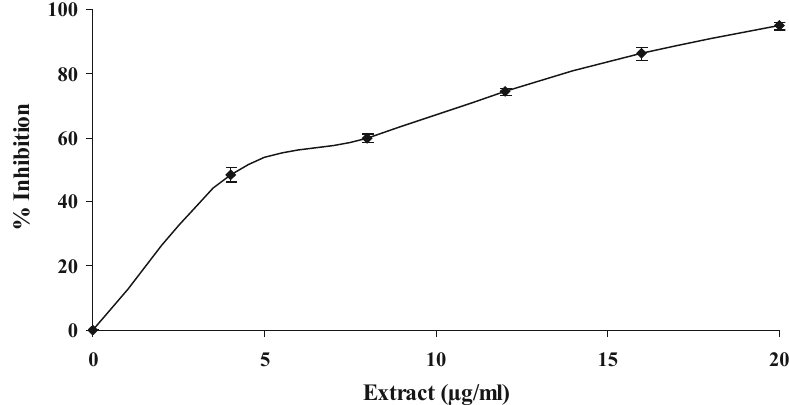
Figure 1 - Dose dependent inhibition of in vitro PLA by aqueous stem bark extract of M. indica . Brie fl y, Phosphatidyl choline (PC) corresponding to 1000 nmol/ml was made up to 680 μ l with NN-XIa-PLA with or without aqueous stem bark extract of M. indica at various concentrations (0-20 μ g/ml) and was incubated with other reaction mixture at 37 °C for 60 min and color developed was read at 540 nm. The results show ± S.E.M. for n=3.